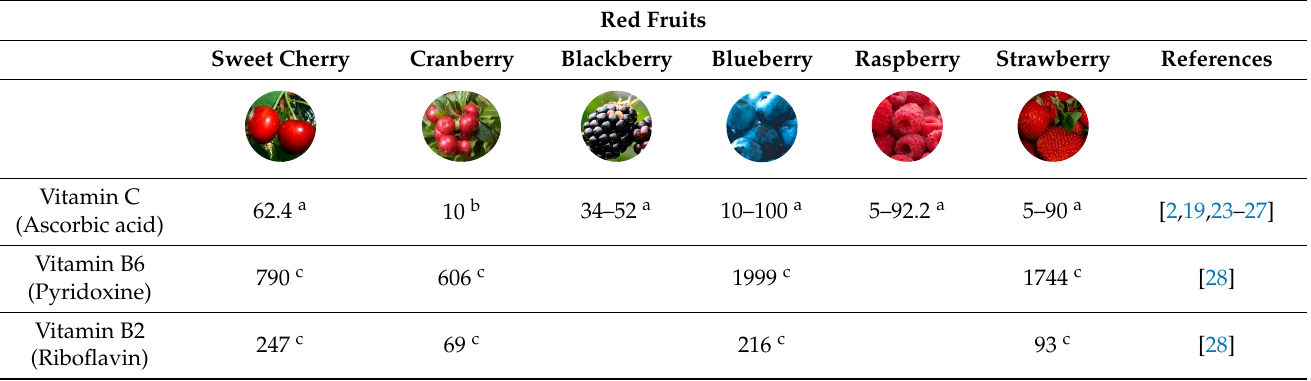
Table 1. The composition in Vitamin C (ascorbic acid) and other vitamins of some red fruits (units at the Table footnote).